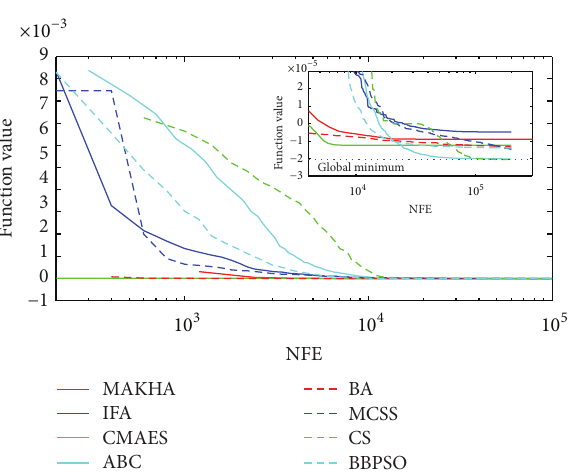
Figure 3: The evolution of the mean best value calculated via the eight metaheuristics versus NFE for problem T9.